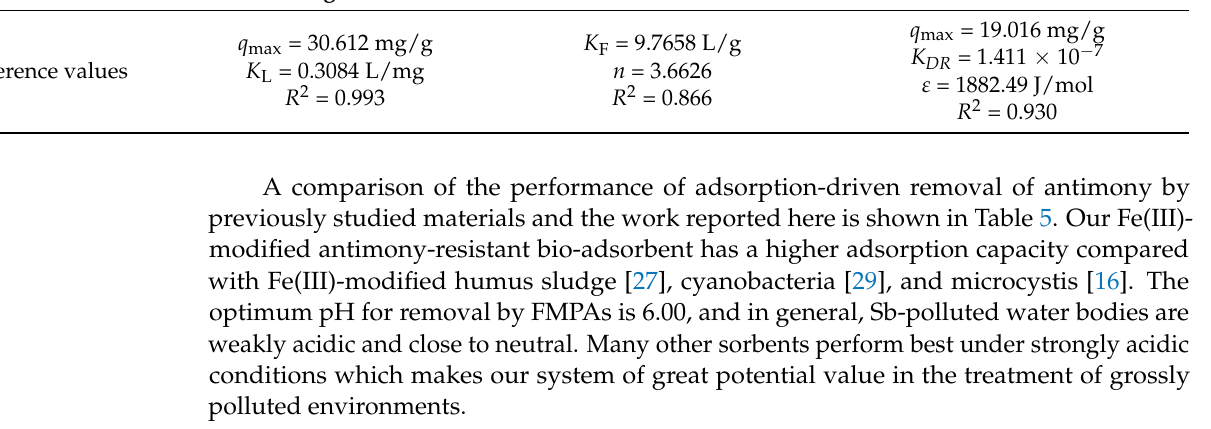
Table 4. The parameters of the isotherm model for Sb(III) adsorption by FMPAs. Model